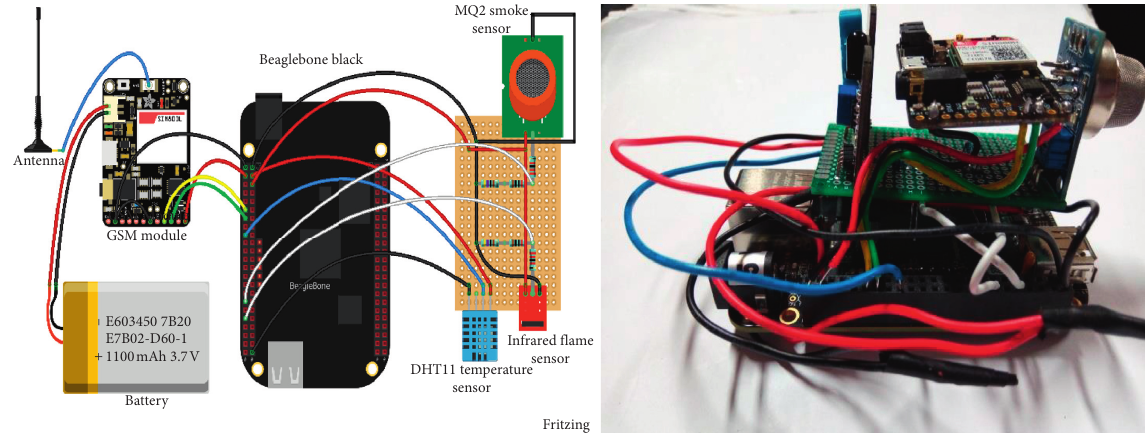
Figure 11: Sensor-based detection hardware